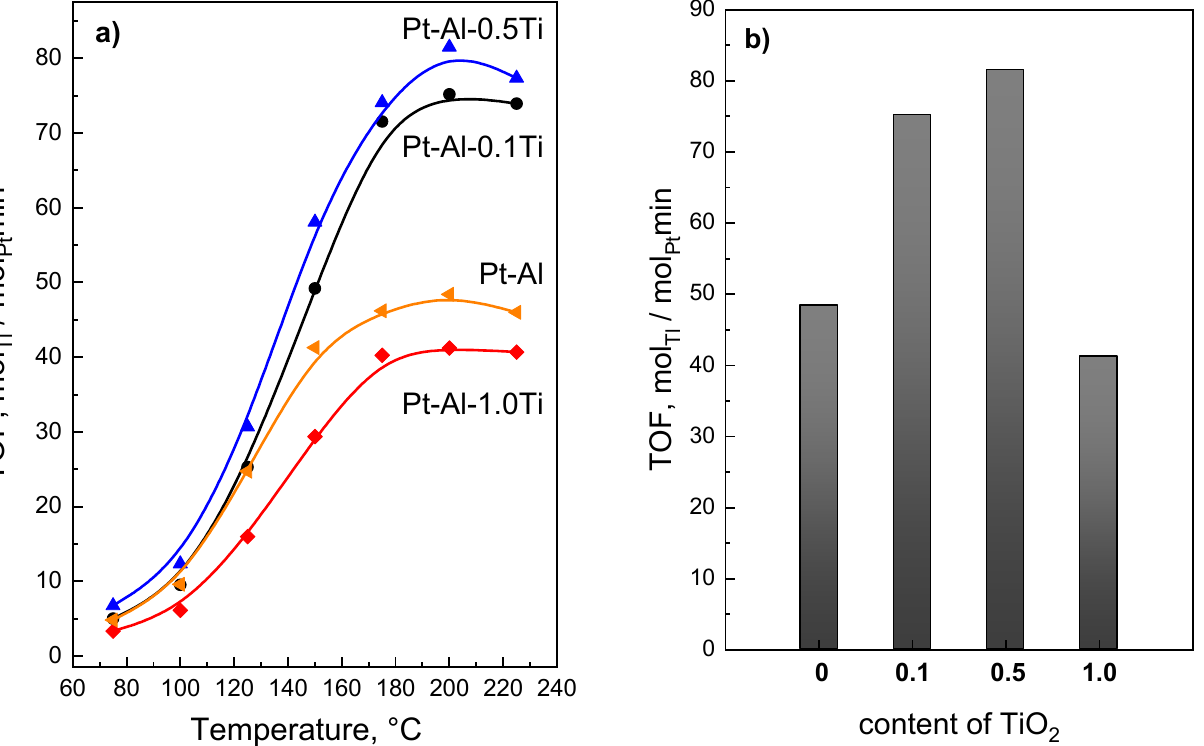
Figure 8. The effect of metallic phase support on TOF (calculated by dividing the number of molecules converted per minute by the number of active (surface) metal atoms measured from irreversibly adsorbed H 2 ) of hydrogenation of toluene as a function of temperature ( a ) and at 200 °C as a function of TiO 2 content ( b ). Catalyst activation conditions: temperature: 400 °C, hydrogen flow: 100 cm 3 ·min − 1 , activation time: 2 h. Reaction conditions: toluene concentration c Tl = 0.75